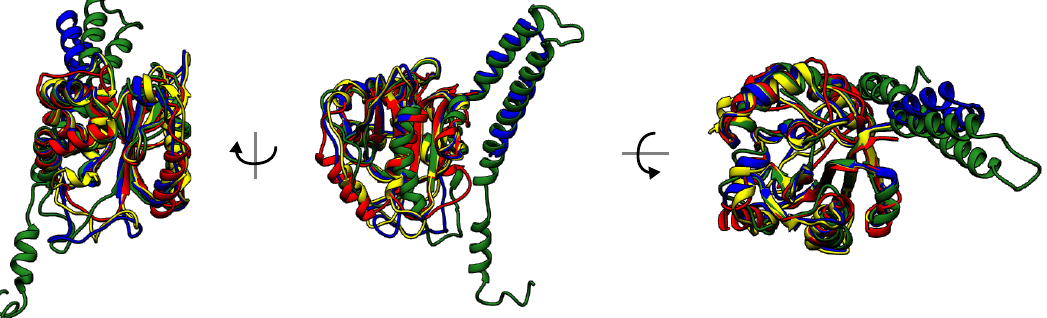
Figure 9. Superimposed structures of UCHs with sequence similarity lower than 30%. Knot-induced rigidity forces the structure